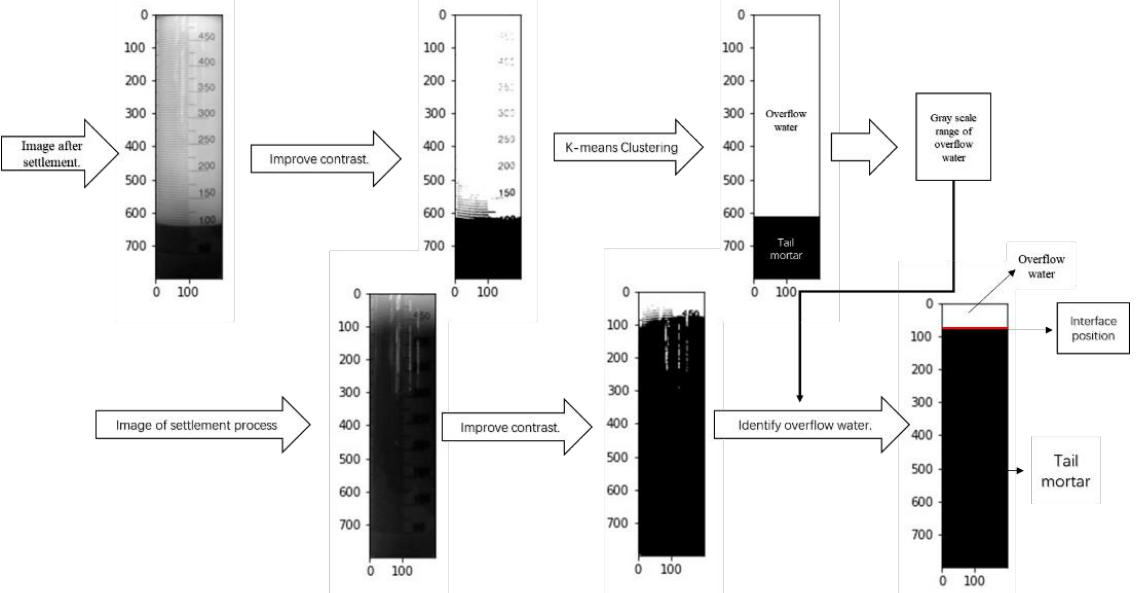
Figure 2. Principle of unsupervised learning to identify settling velocity of